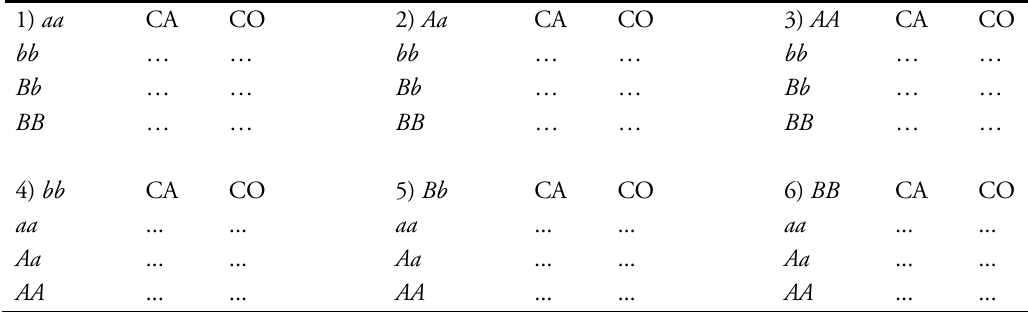
Figure 5 – Possible